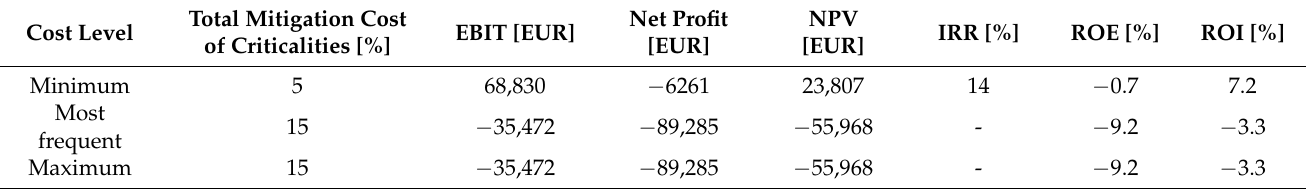
Table 13. Results of the sensitivity analysis conducted considering critical levels typical of multi- family buildings before the introduction of CILAS and assuming critical mitigation costs equal to the minimum, maximum, and most frequent